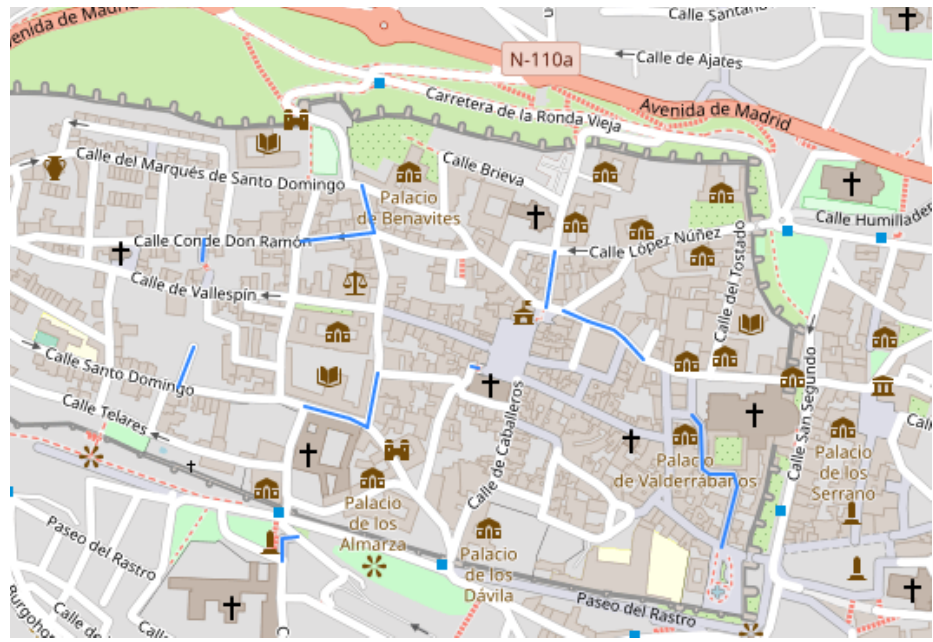
Figure 3. Problematic streets. In blue, we show all streets labeled as intermediate difficulty (see the orange color level in Table